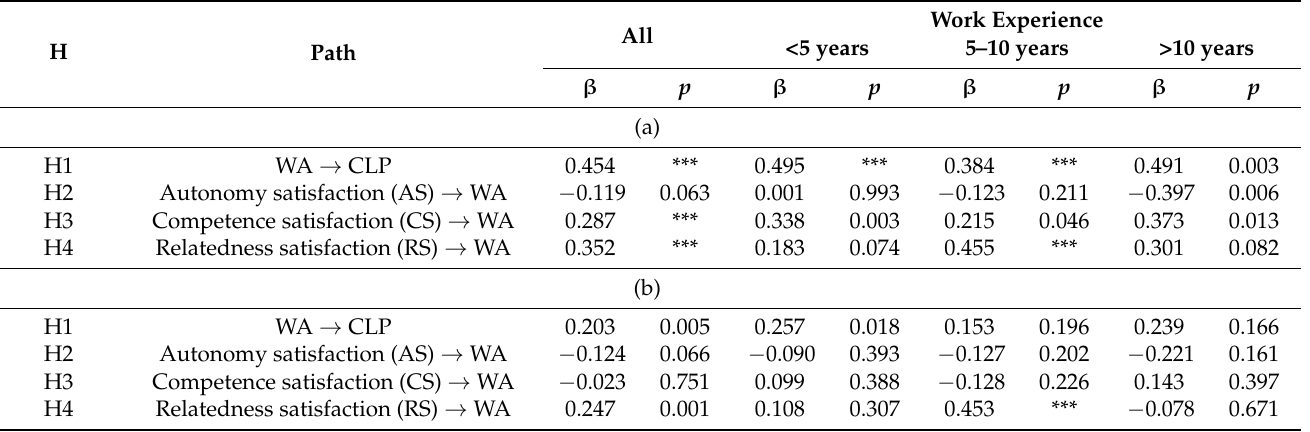
Table 8. (a) Results of regression analyses associated with the four hypotheses (for AMI). (b) Results of regression analyses associated with the four hypotheses (for